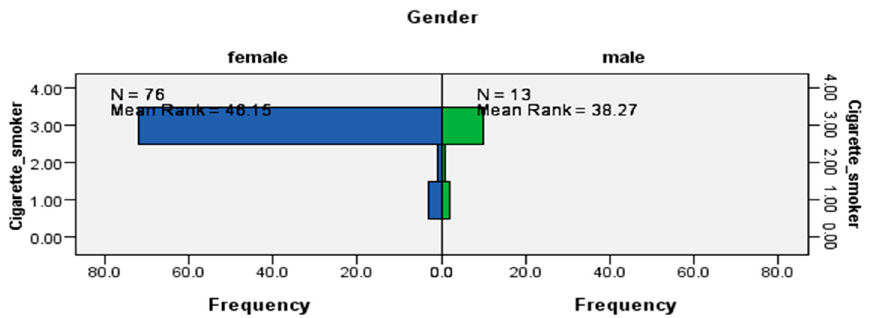
Figure 2. Independent-samples Mann–Whitney U test of the distribution of cigarette smoking across sex.